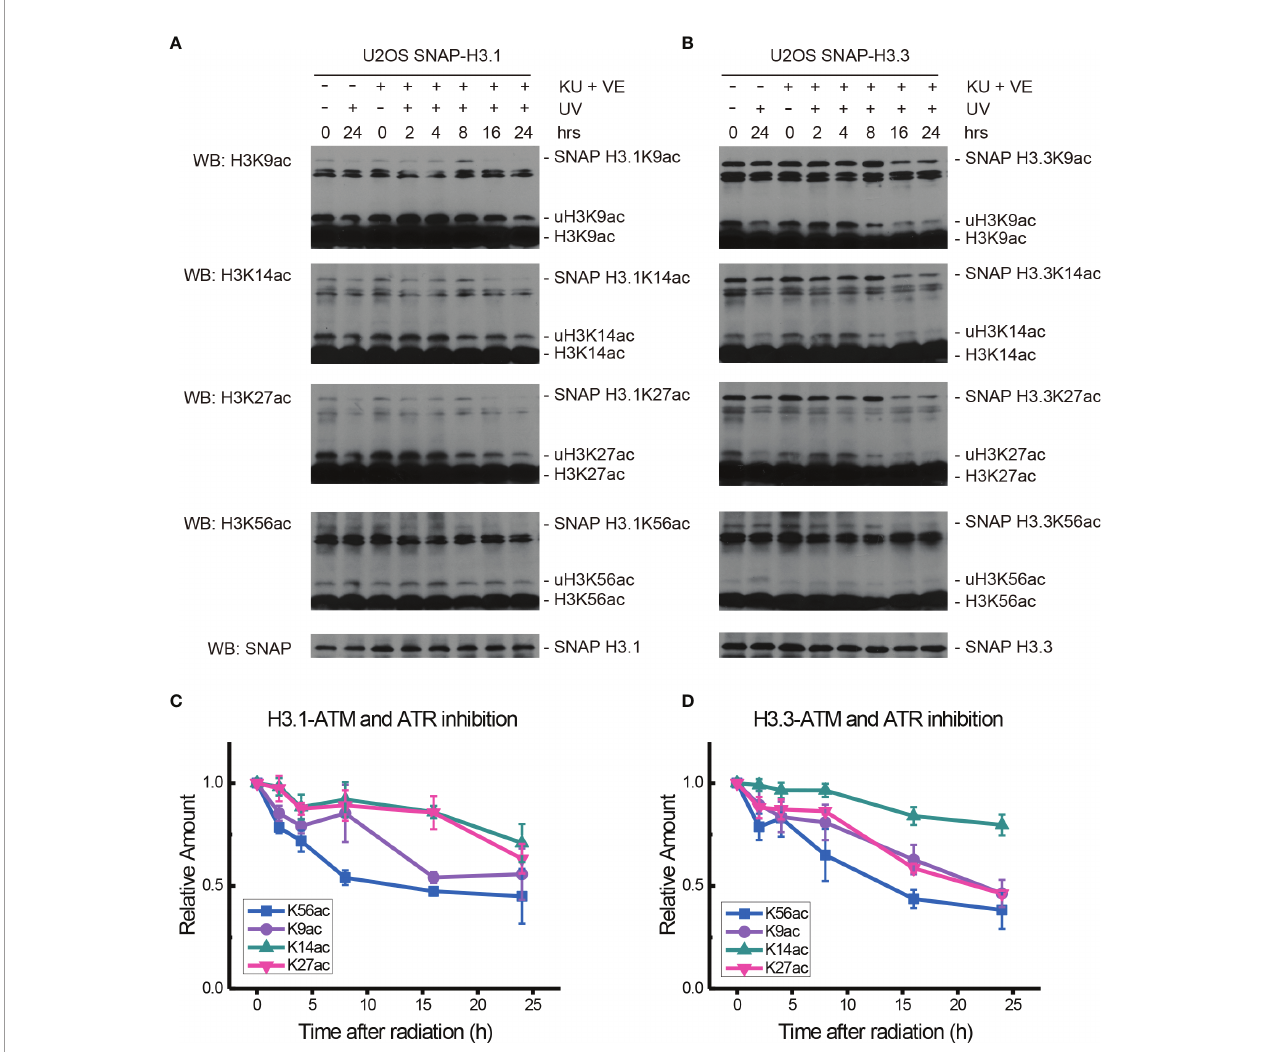
FIGURE 4 | Modulation of acetylated K9, K14, K27, and K56 of histone H3.1 or H3.3 by an ATM inhibitor, ATR inhibitor, and UV radiation. (A) H3.1-SNAP U2OS cells were pretreated with DMSO (-) or KU55933 and VE-821 (+) for 1 h and then irradiated with 20 J/m 2 UV radiation. The insoluble nuclear protein samples were collected at 0 h, 2 h, 4 h, 8 h, 16 h, and 24 h after radiation. The acetylation levels of H3K9, H3K14, H3K27, and H3K56 were examined. SNAP-tagged histone H3 was used as an internal reference. (B) H3.3-SNAP U2OS cells were pretreated with DMSO or two inhibitors and then irradiated with 20 J/m 2 UV radiation. The insoluble nuclear protein samples were collected, and the acetylation levels of H3K9, H3K14, H3K27, and H3K56 were examined. SNAP-tagged histone H3 was used as an internal reference. (C) Time-course alteration of acetylated K9, K14, K27, and K56 of histone H3.1 after 20 J/m 2 UV radiation and two inhibitor treatments. The data are normalized immunoblotting results by ImageJ analysis from three separate experiments. (D) Time-course alteration of acetylated K9, K14, K27, and K56 of histone H3.3 after 20 J/m 2 UV radiation and two inhibitor treatments. The data are normalized immunoblotting results by ImageJ analysis from three separate